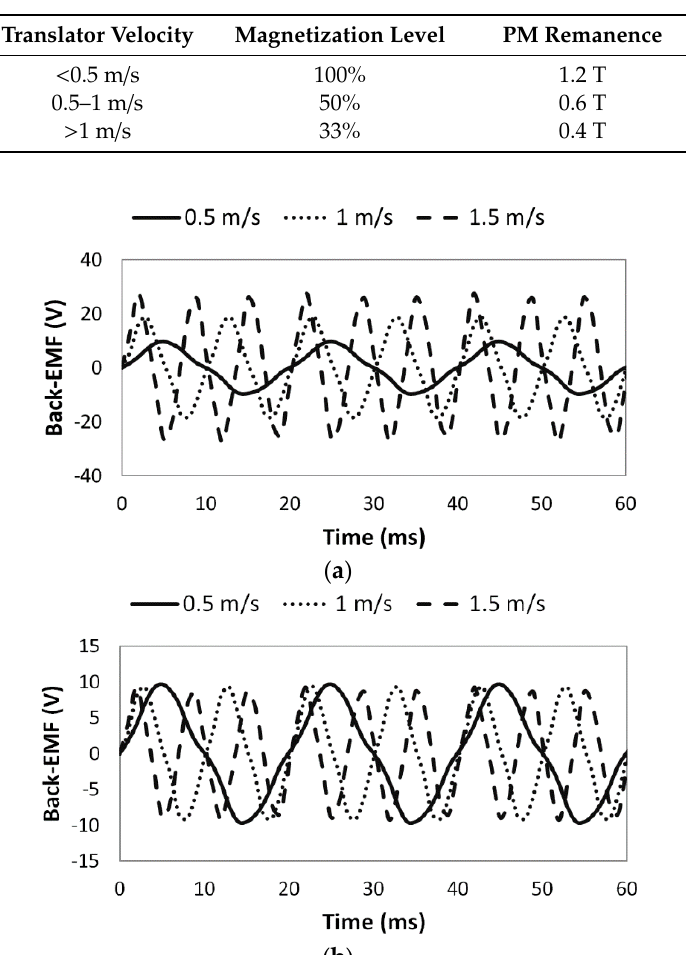
Figure 9. Back-EMF under different translator speeds: ( a ) without flux regulation and ( b ) with flux regulation.